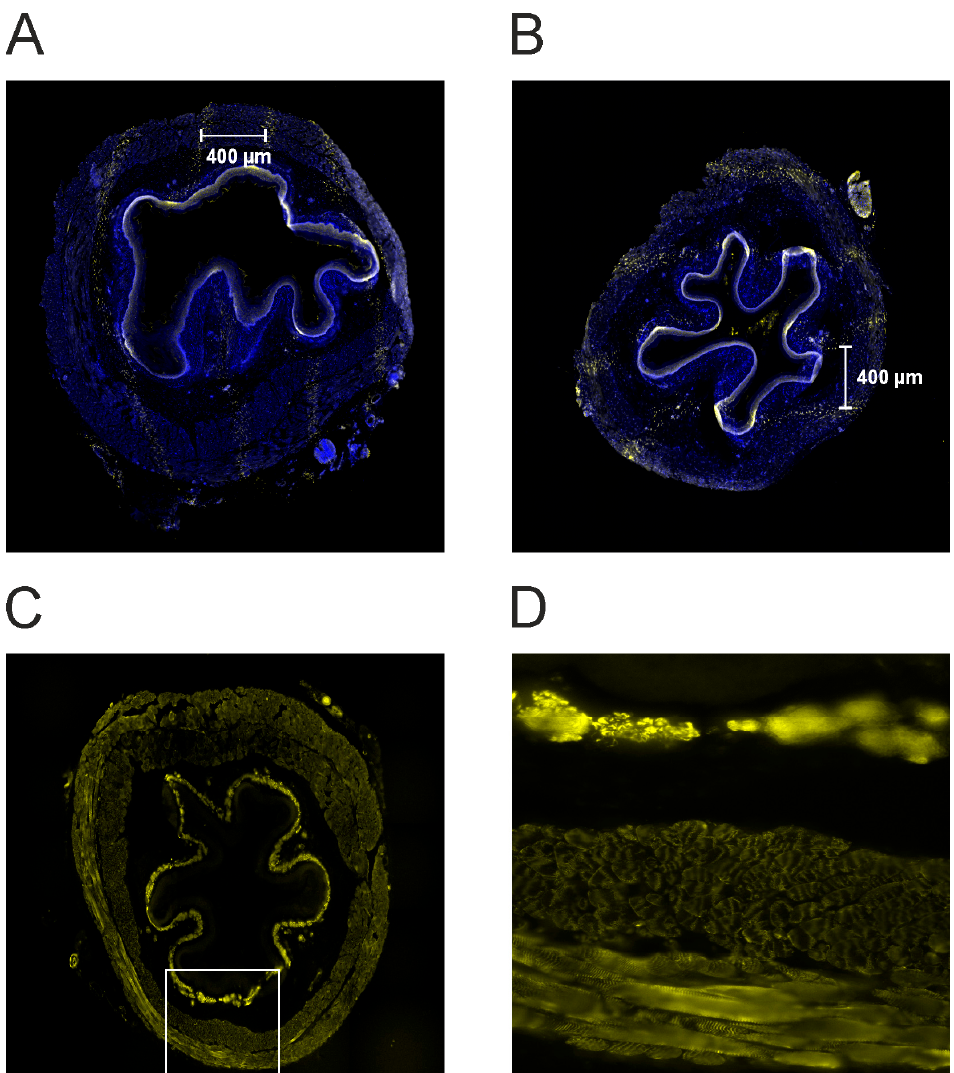
Figure 5. ( A , B ) Photographs of the tissue after γ H2AX immunostaining for a proximal (panel A) and a middle segment (panel B). Following microbeam irradiation, the immunostaining shows the characteristic pattern of DNA-double strand breaks (yellow dots). This illustrates the dose deposition of the microbeams in the esophagus. The microbeams are separated from each other by approximately 400 µm from center-to-center. ( C , D ). Desmin immunostaining for the same segment (see panel A). Panel D is an enlargement of panel C (40-fold, white rectangle in C). The smooth muscle is strongly stained. The different muscle layers can be seen.